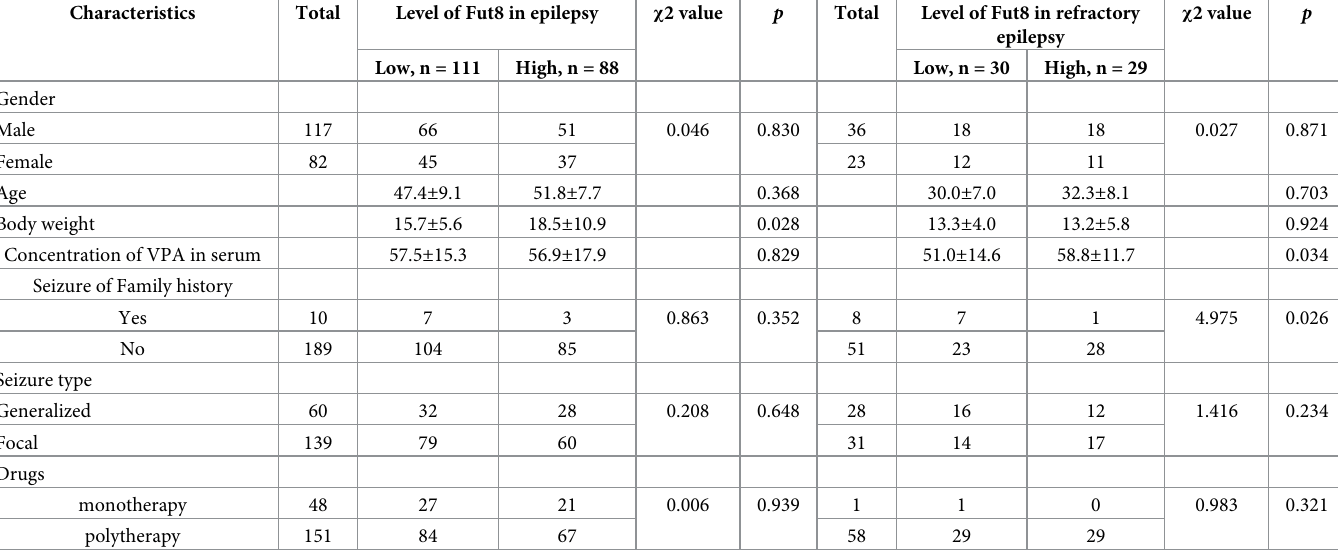
Table 3. Correlations between the serum Fut8 with clinical characteristics in epilepsy and refractory epilepsy group.